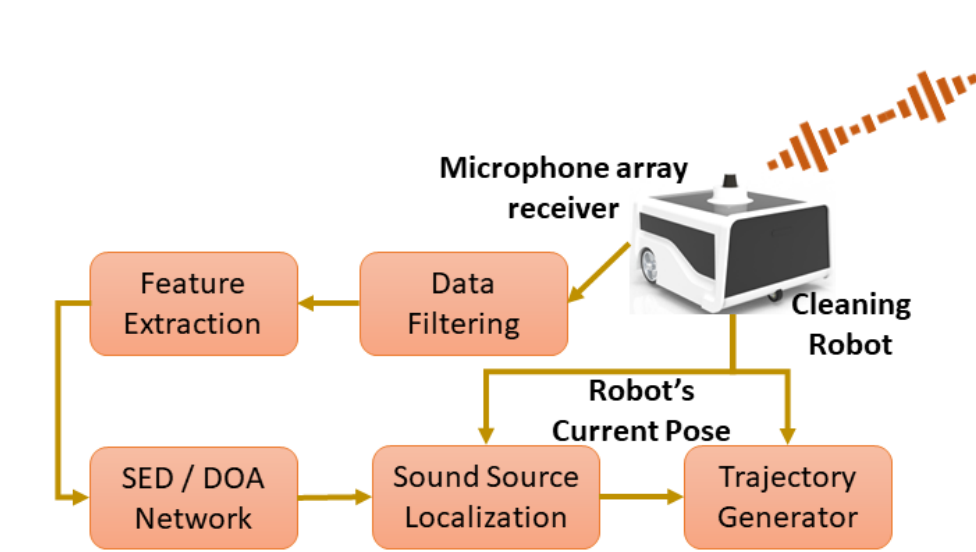
Figure 2. Overview of the sound source detection and avoidance on the floor cleaning